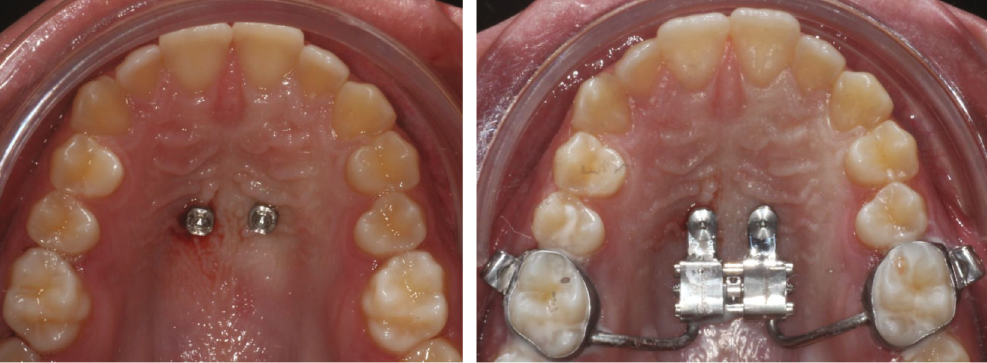
Figure 8: Implants and hybrid RME